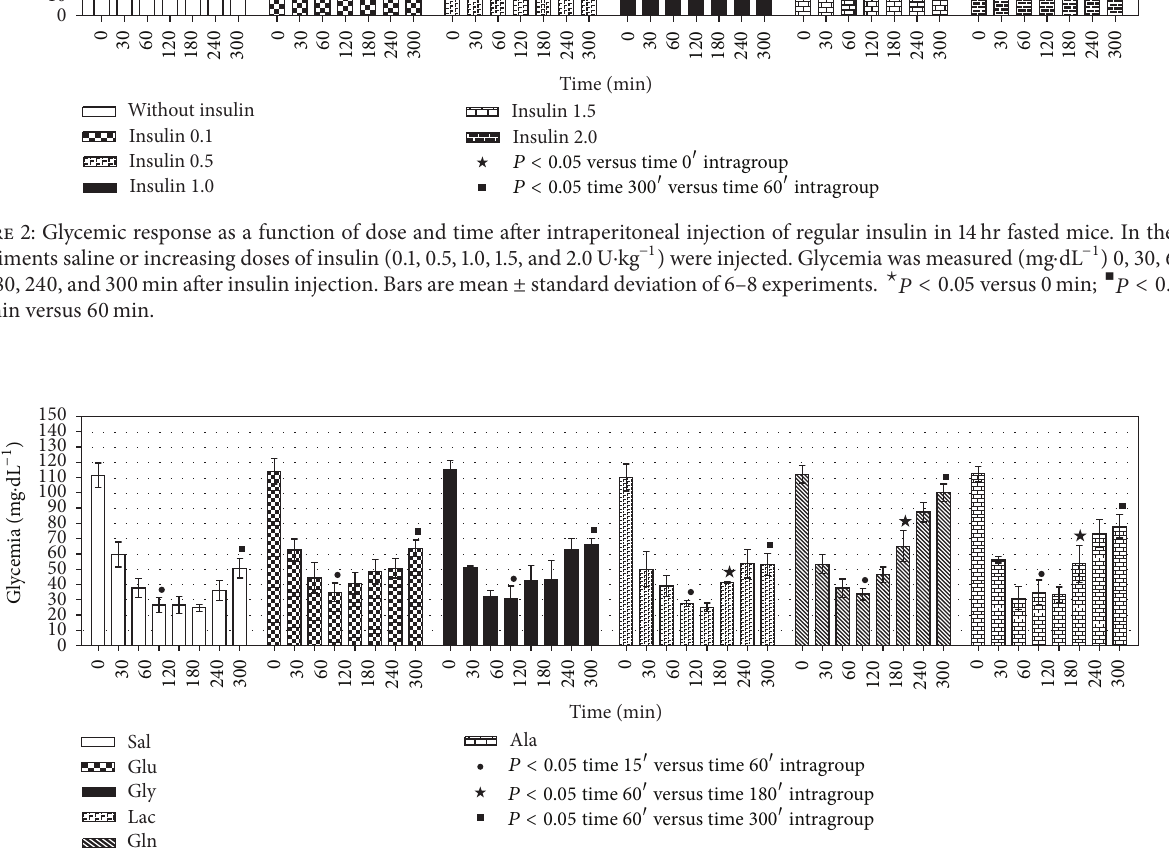
Figure 3: Glycemic response after oral administration of saline (Sal), glucose (Glu), glycerol (Gly), lactate (Lac), glutamine (Gln), or alanine (Ala) during insulin-induced hypoglycemia (IIH). IIH was induced in 14hr fasted mice with an intraperitoneal injection of regular insulin (1.0U ⋅ kg −1 ). Glycemia (mg ⋅ dL −1 ) was determined 0, 15, 30, 60, 120, 180, 240, and 300 min after insulin injection. The oral administration of Sal, Glu (100mg ⋅ kg −1 ), Gly (100mg ⋅ kg −1 ), Lac (100mg ⋅ Kg −1 ), Gln (100mg ⋅ kg −1 ), and Ala (100mg ⋅ kg −1 ) was done 15 min after insulin injection. The bars express the mean ± standard deviation of 6–8 experiments. ∙ 𝑃 < 0.05 15min versus 60min, 󳀅 𝑃 < 0.05 60 min versus 180min, and ◼ 𝑃 < 0.05 60min versus